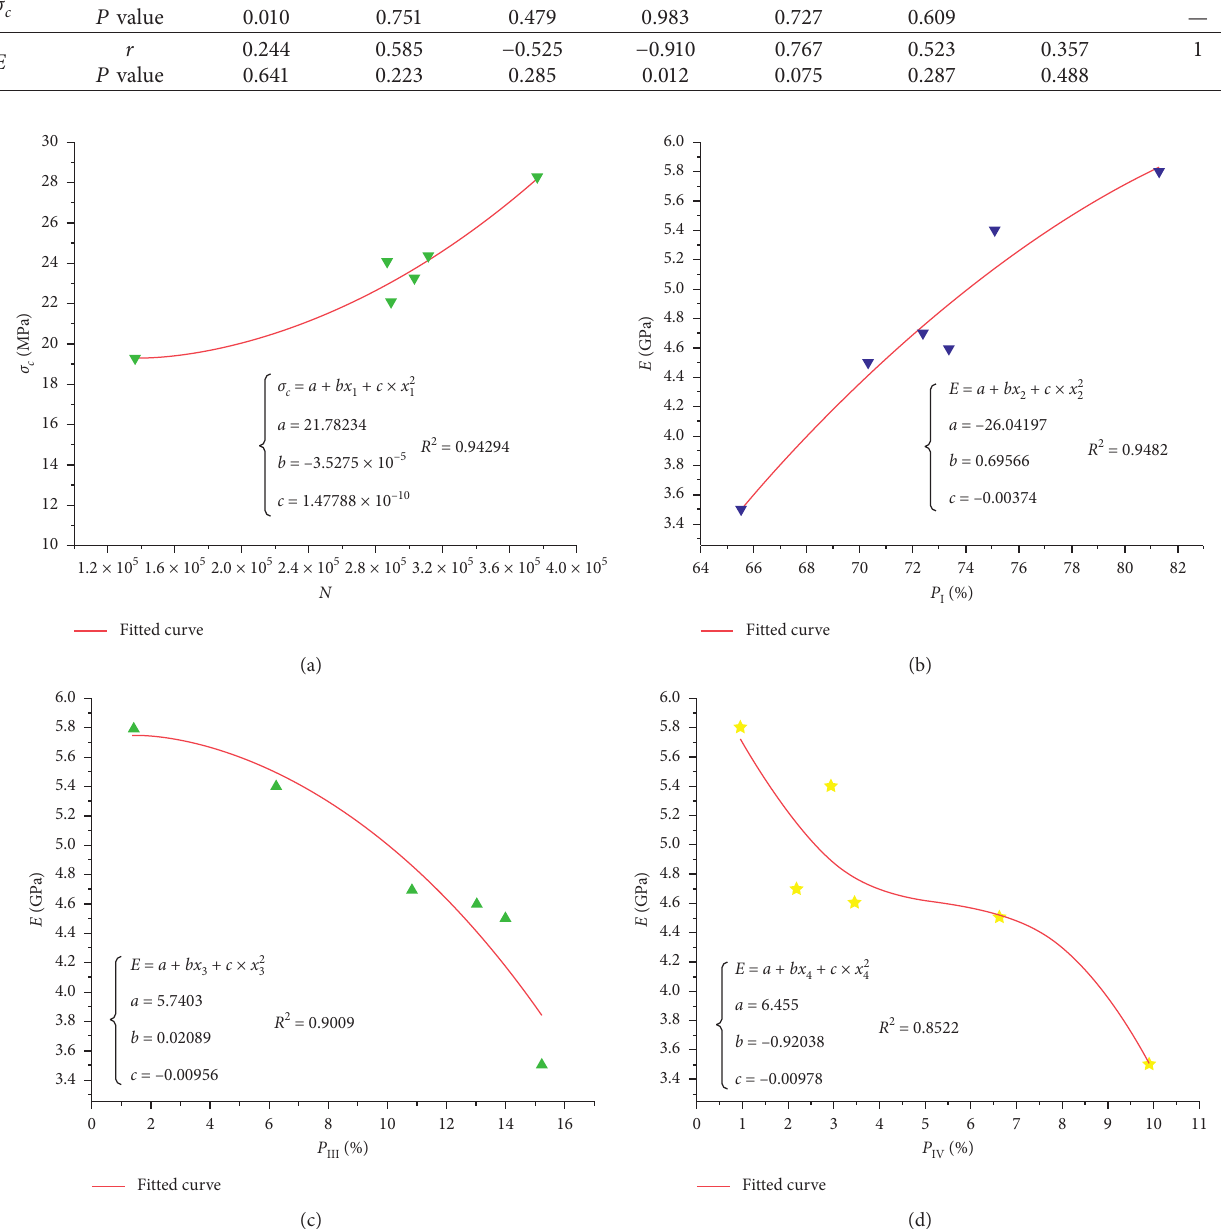
Figure 15: Fitted curves of microstructural and macroscopic mechanical parameters. (a) Fitted curve of N and σ P I . (c) Fitted curve of E and P III . (d) Fitted curve of E and P IV